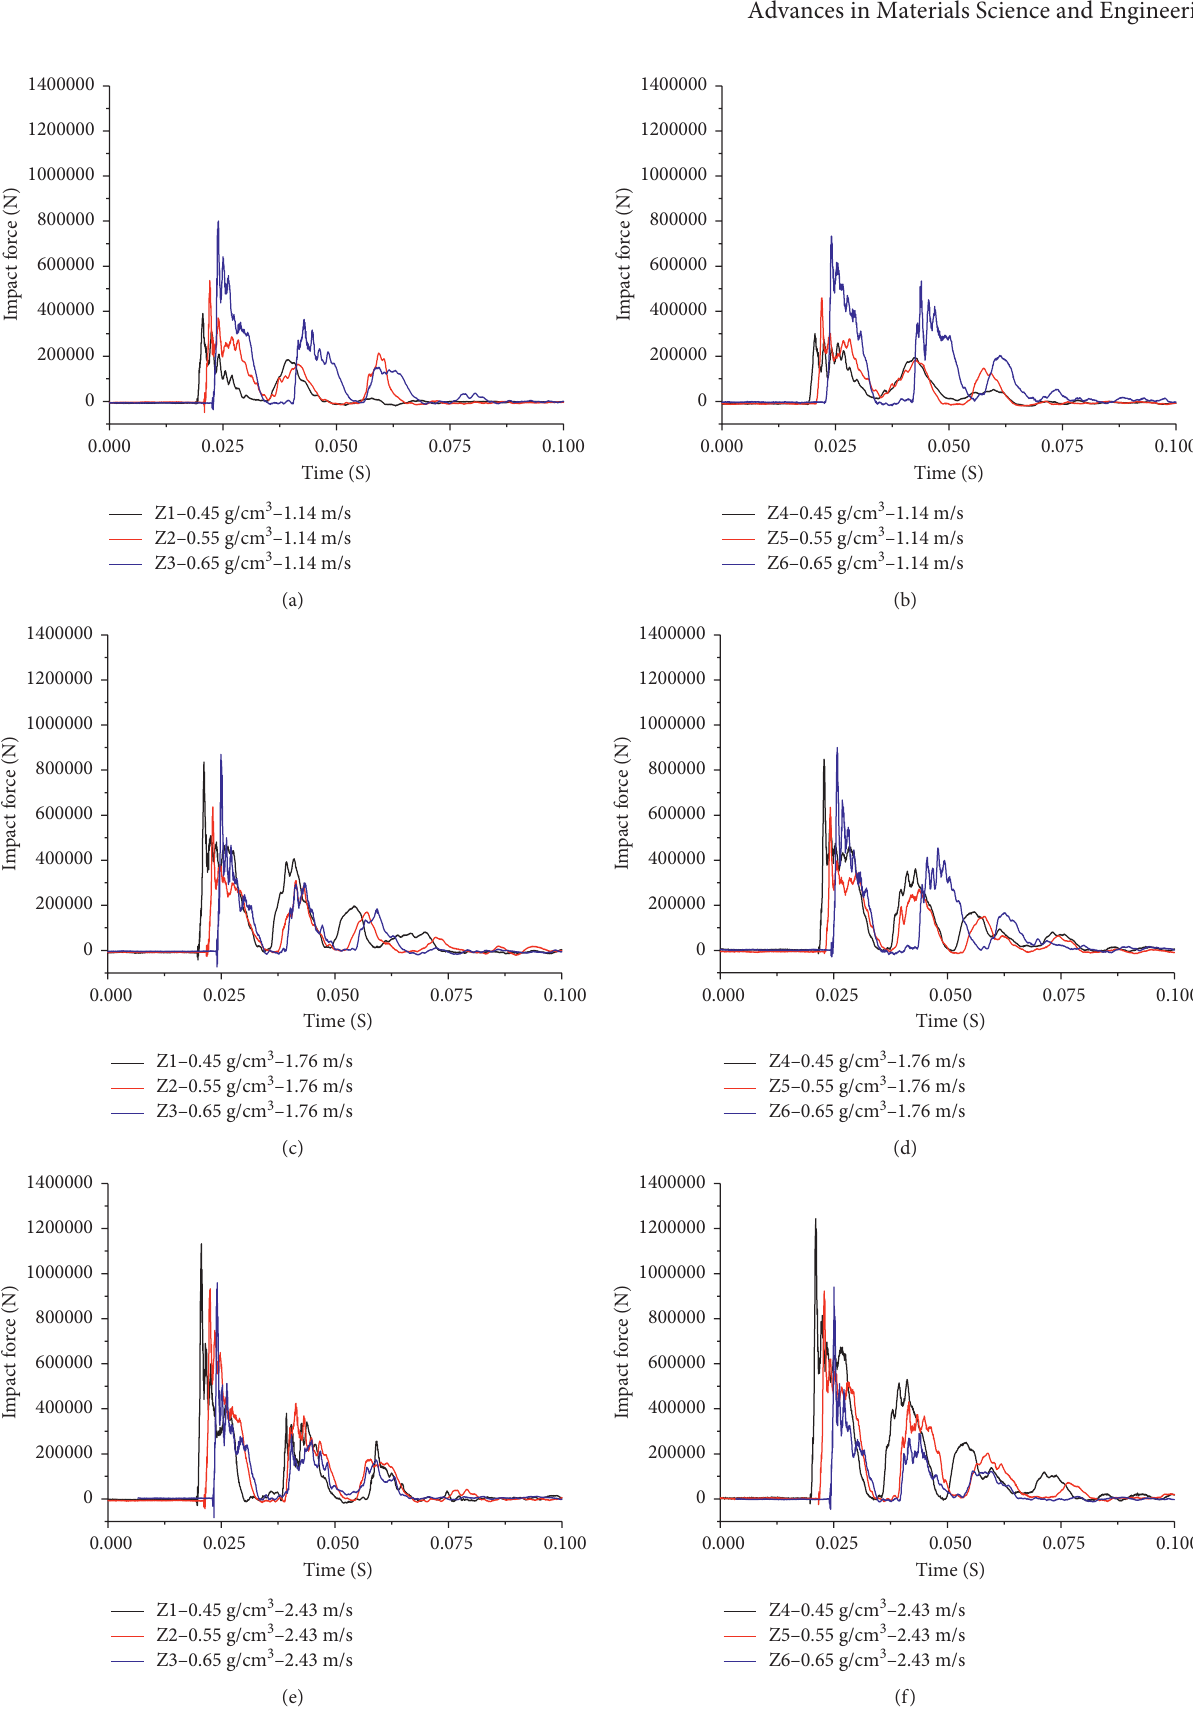
Figure 9: Time history curves of the impact